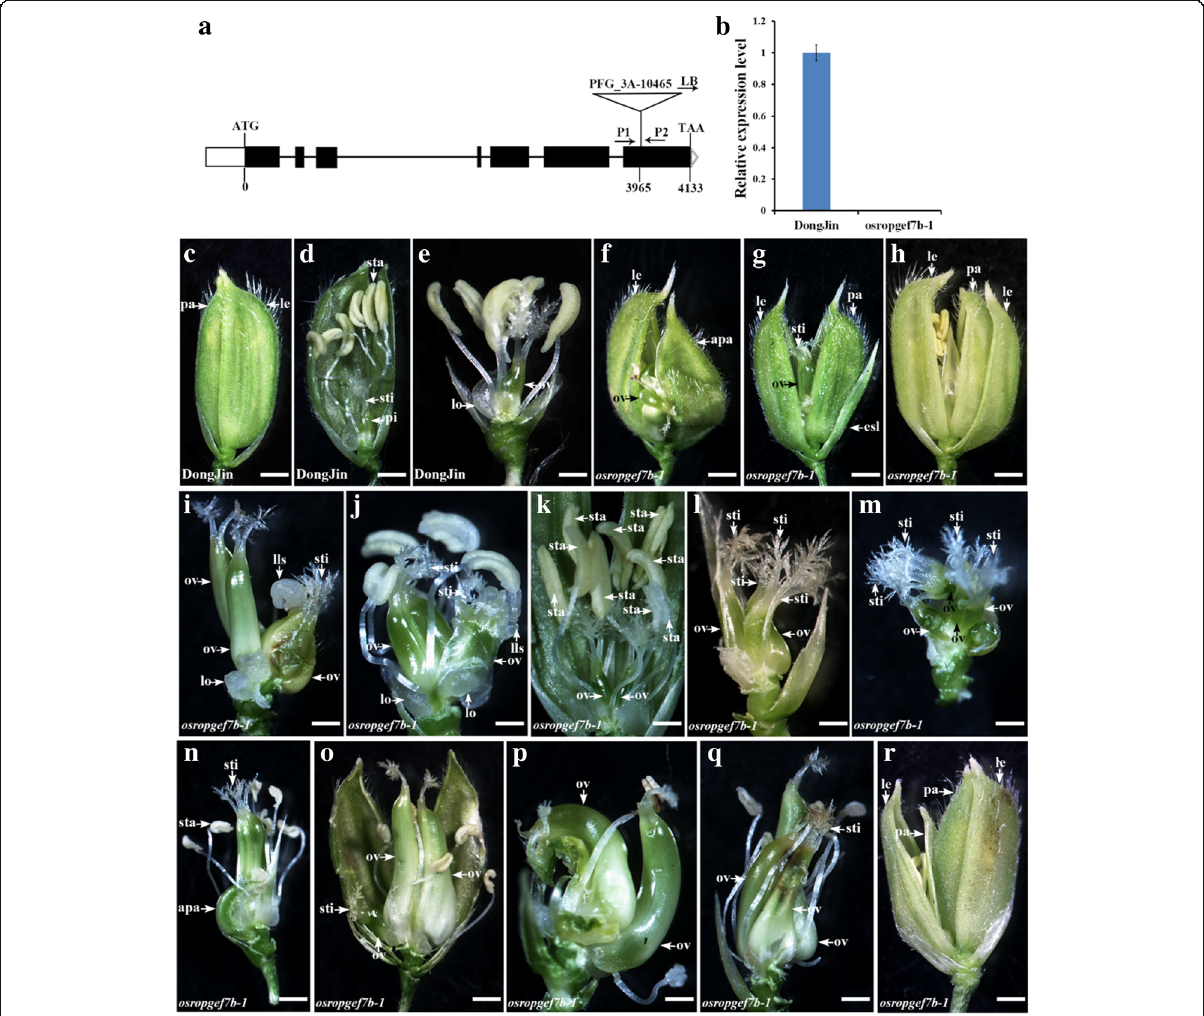
Fig. 2 Knock-out of OsRopGEF7B induces severe developmental defects in floral organ. a Structure of OsRopGEF7B . Black boxes indicate exons, black thin lines between exons indicate introns, white boxes indicate UTRs. The T-DNA insertion site in the seventh exon of osropgef7b-1 (PFG_3A- 10,465) is shown and P1 and P2 indicate the sites of primers used for identifying the T-DNA insertion. b Transcript level of OsRopGEF7B in osropgef7b-1 compared with wild type (DongJin). c - r Floral phenotypes of osropgef7b-1 compared with wild type. Lemmas/paleae and stamens were partially or totally removed to display the inner organs. c - e ) Wild type flowers. f - r ) osropgef7b-1 flowers with different phenotypes. f A flower with one normal lemma and one abnormal palea, and an enlarged ovary coming out from the shells (lemma/palea). g A flower with an elongated sterile lemma. h A sterile lemma transformed into a lemma structure. i - j Flowers have multiple ovaries with lodicules-like structure ectopic growth upon the top of ovary. (K) A flower with two ovaries and nine stamens. l - m ) Flowers with multiple ovaries and stigmas. ( n - q ) Flowers with multiple fused or separated ovaries. r Two flowers in different sizes on a receptacle. Apa, abnormal palea; esl, elongated sterile lemma; glo, glume-like organ; le, lemma; lls, lodicules-like structure; lo, lodicules; ov, ovary; pa, palea; pi, pistil; sta, stamen; sti, stigma; Scale bars: ( c to r ) 1 of both osropgef7b-1 mutant (Additional file 1: Figure RNAi L31 plant (Additional file 1: Figure S3B, D, I) are S4D-F, M) and RNAi L31 plant (Additional file 1: Figure same to those of the wild type controls (Additional file 1: S4J-M) were not different from those of the wild type (Add- Figure S3A, C, I). Results of DAPI staining showed that all itional file 1: Figure S4A-C, G-I, M), indicating that the the fertile pollen grains from osropgef7b-1 , RNAi L31 and knock-out or -down of OsRopGEF7B did not affect pollen the wild type contained three nuclei: two bright, intensely tube elongation. Taken together, our data suggest that the stained sperm nuclei and one diffused, weakly stained vege- reduced seed setting of osropgef7b-1 mutant and RNAi tative nucleus (Additional file 1: Figure S3E-H). The DAPI plants might be partly attributable to the defects in female analysis indicated that the knock-out or -down of OsRop- GEF7B did not affect pollen development. We also found organ development, as pollen development and pollen tube growth in osropgef7b-1 and RNAi plants are quite normal. that pollen tube elongation and pollen germination in vivo